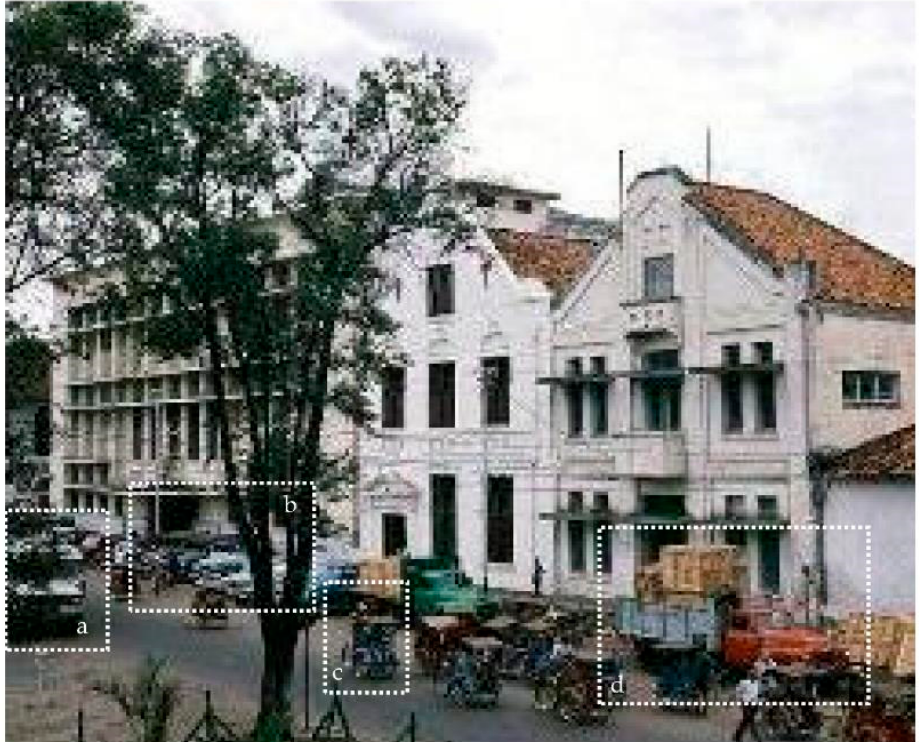
Figure 14. Daily activities at the surrounding of Jakarta History Museum in 1971. Identified sound sources: ( a ) a bus ( b ) vehicles ( c ) rickshaws ( d ) loading-unloading materials. Source: Collection of Tropenmuseum.